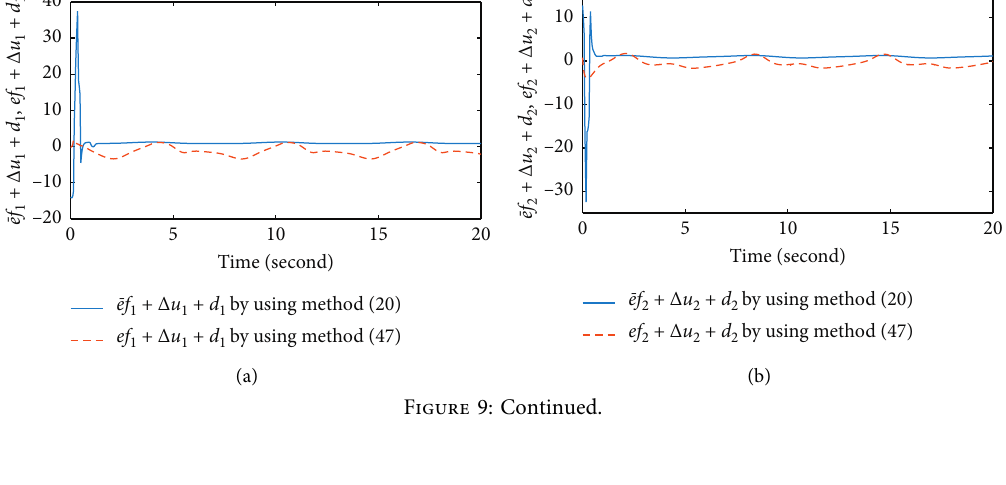
) , sat ( u ) , and sat ( u 1 2